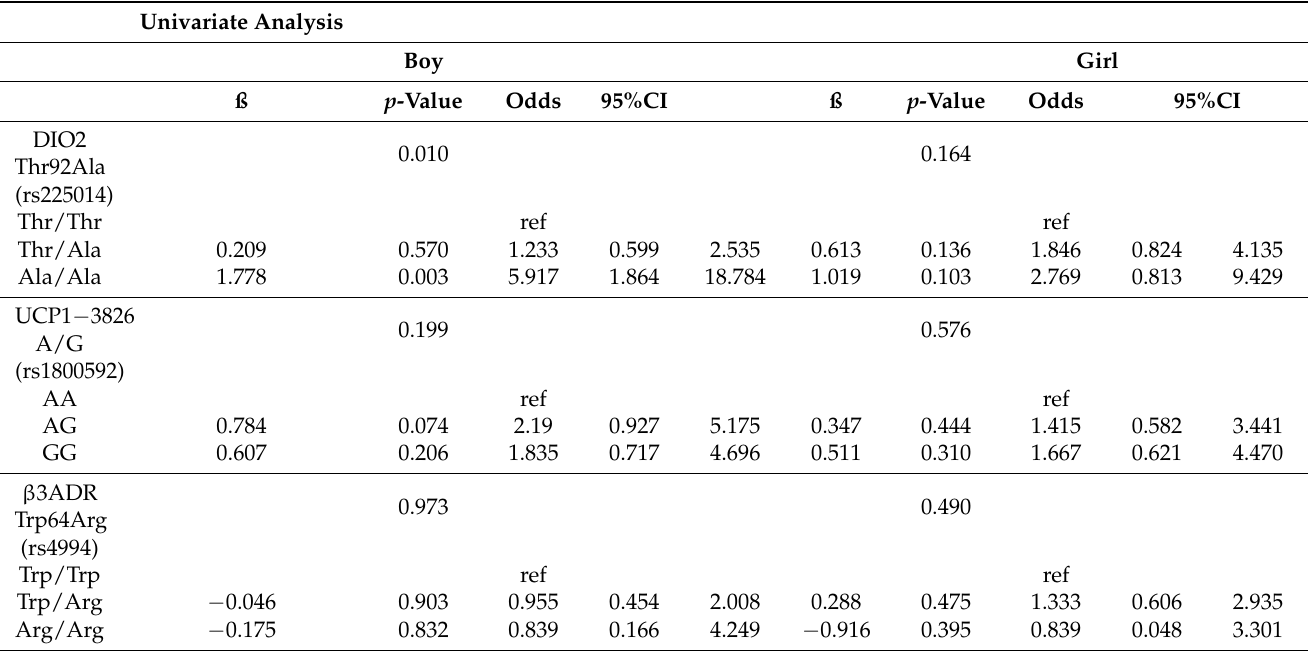
Table 9. Univariate and multivariate analyses with respect to obesity classified based on the percent- age of